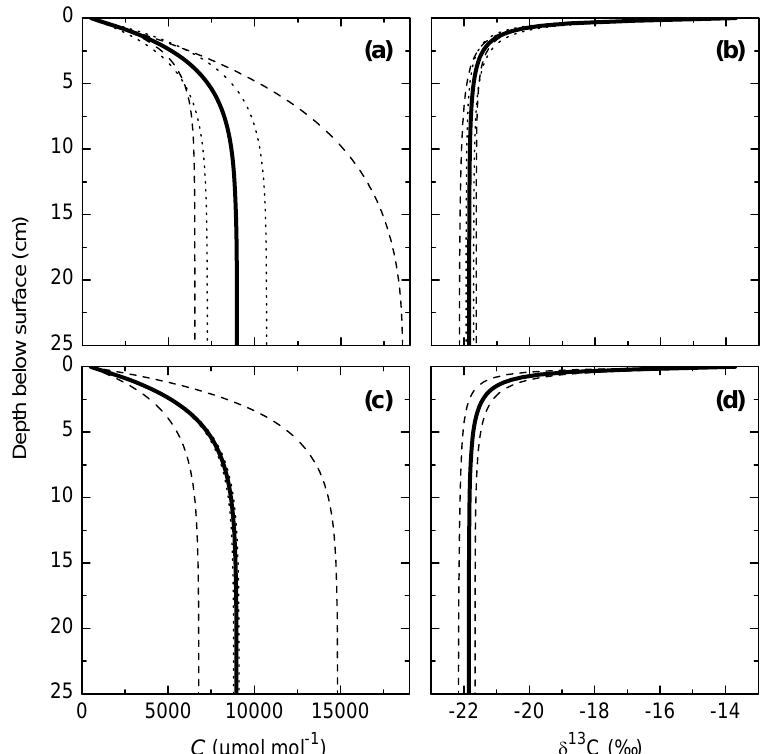
Fig. 3. Modelled depth profiles (thick black lines) of soil CO 2 mole fraction C (a, c) and isotopic composition δ 13 C (b, d) under ambient conditions (the beginning of the labelling experiment) for soil conditions observed at the experimental field site. Sensitivity of each to variations in input parameters within the observed range (Table 1) is indicated by the thin dashed or dotted lines. Upper panels (a, b) : depth profiles when depth distribution of CO 2 production in soil (dashed) and soil respiration rate (dotted), respectively, were varied. Lower panels (c, d) : depth profiles when soil porosity (dashed) and temperature (dotted), respectively, were